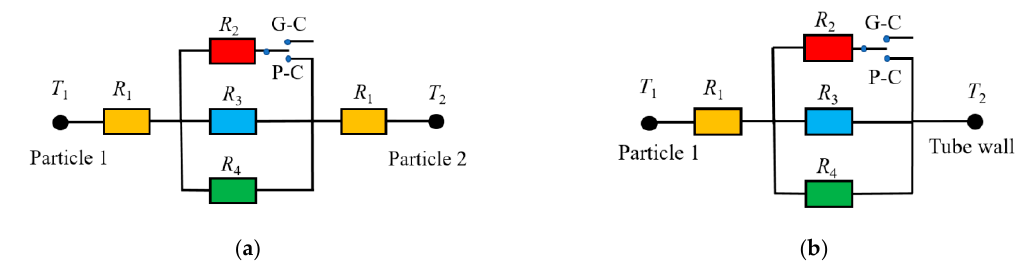
Figure 2. Schematic of thermal resistance network: ( a ) the case for particle–particle; ( b ) the case for particle–wall ( R 1 : thermal conduction resistance inside particles; R 2 : physical contact thermal conduction resistance; R 3 : thermal conduction resistance through gas film; R 4 : thermal radiation resistance; “G-C” means contact only with gas film; “P–C” means physical contact).